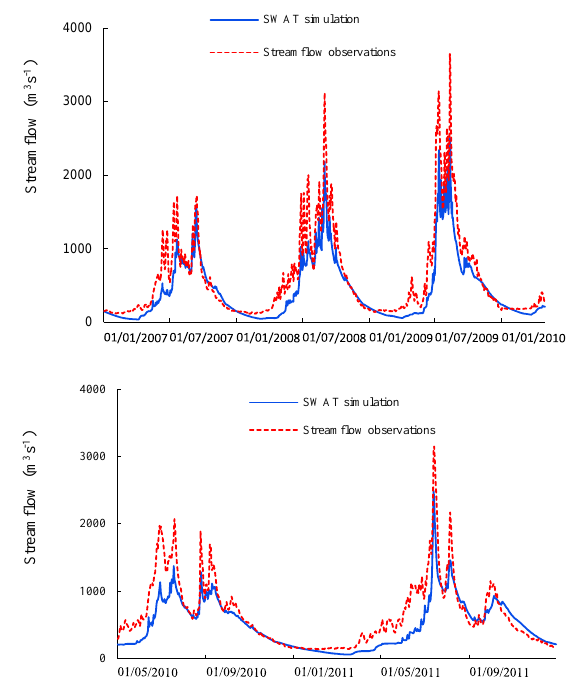
Figure 3. SWAT simulated streamflow for the basin in both the calibration and validation